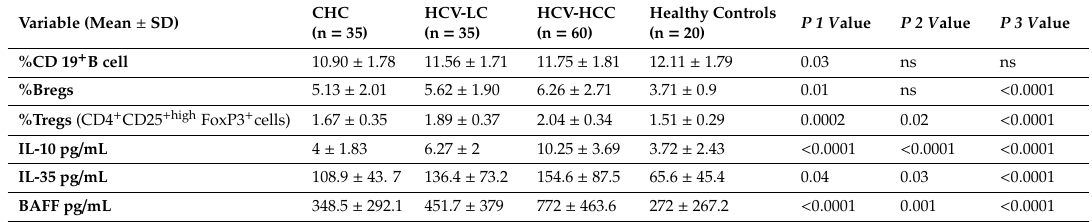
Table 2. Bregs, Tregs, IL-10, IL-35 and BAFF levels in the studied